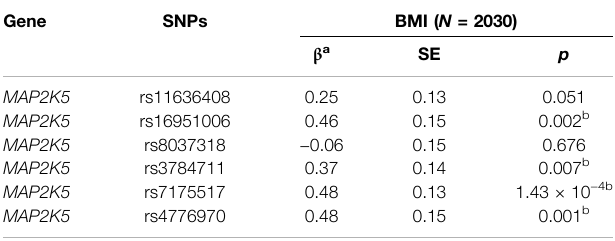
TABLE 1 | Association of MAP2K5 genetic variants and BMI in Chinese children.